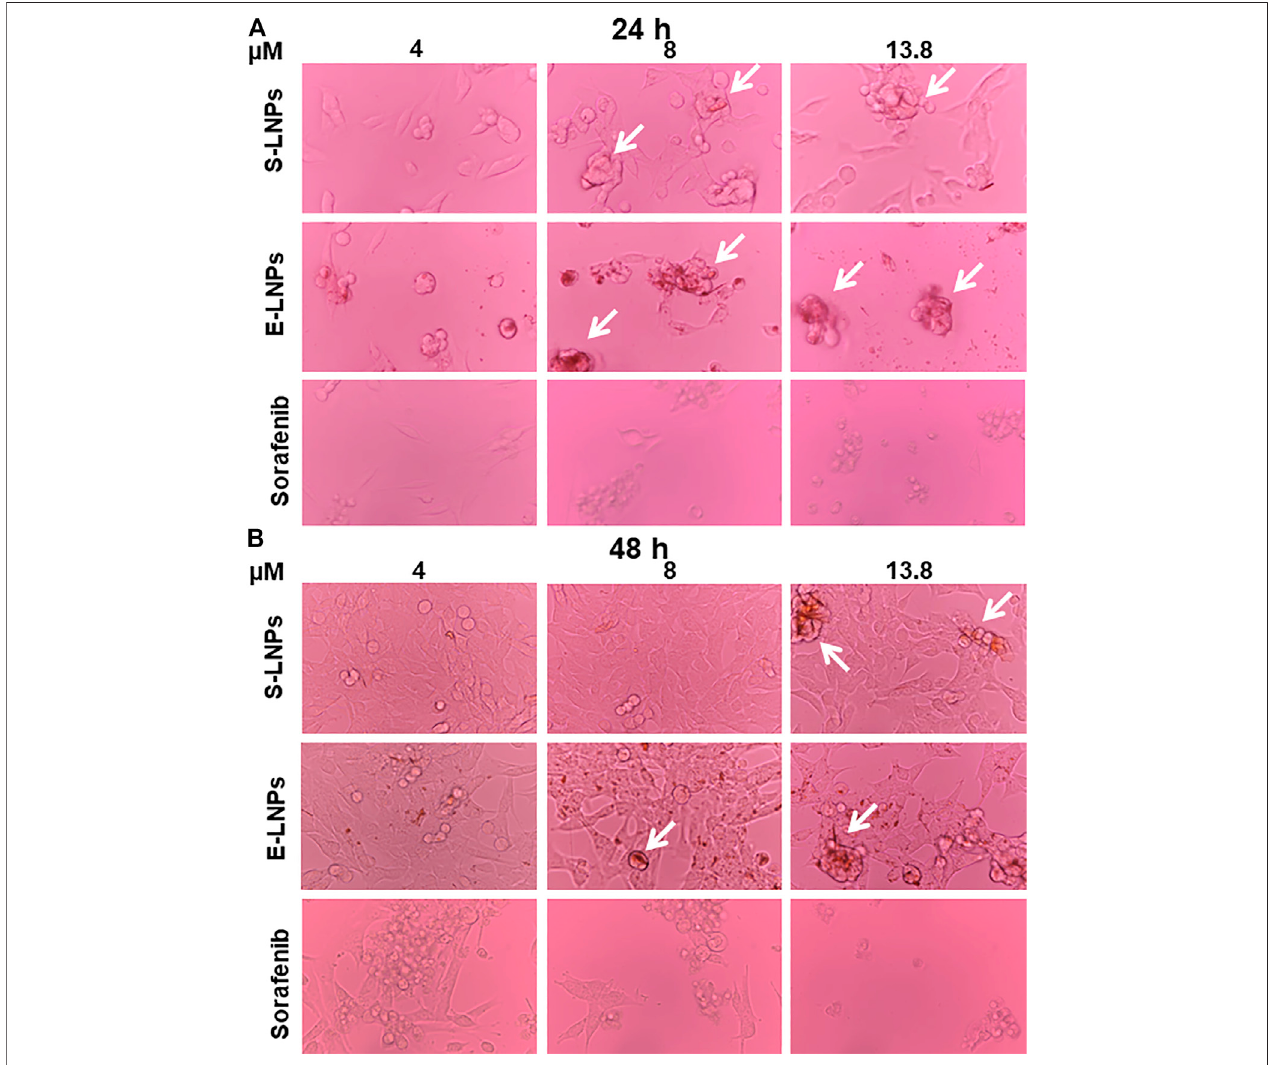
FIGURE 7 | Microscopy showed a dose-dependent inhibition of HCC cells and accumulation of yellowish conglomerates in LNP-treated groups. HCC cells were treated with S-LNPs, E-LNPs, and standard therapy sorafenib. Bright- fi eld microscopy (magni fi cation ×40) was performed (A) 24 h and (B) 48 h post-incubation. Yellowish conglomerates are depicted with the white arrows. Details on all control groups are shown in Supplementary Figure S10